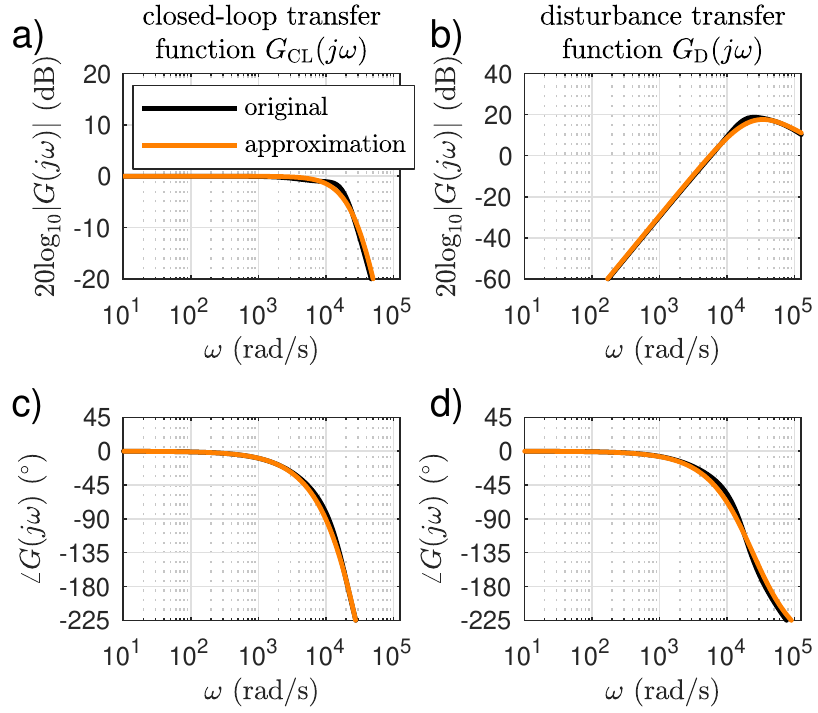
Figure 10. Comparison of the Bode diagrams for the approximated and original frequency responses of the current control system: ( a , c ) amplitude and phase characteristics of the closed-loop frequency responses, ( b , d ) amplitude and phase characteristics of the disturbance frequency